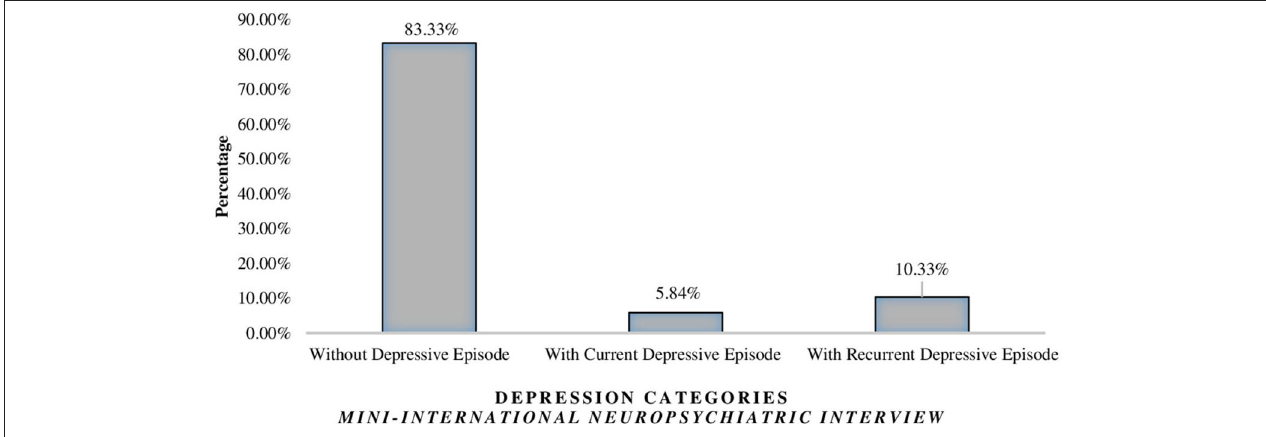
FIGURE 1 | Prevalence of major depressive episodes in farmers according to the MINI scale version